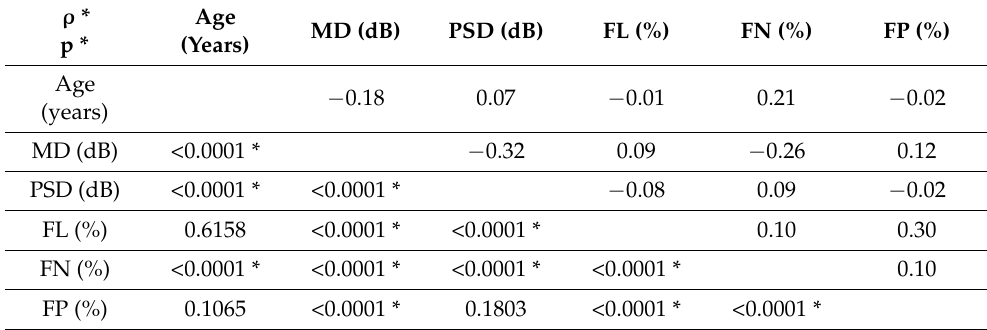
Table 2. Possible associations between each parameter tested by a univariate analysis.